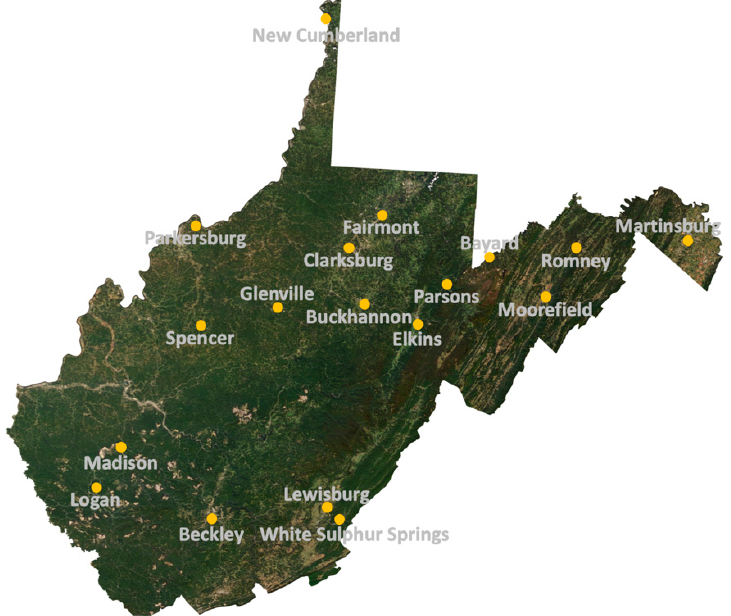
Figure 1. Observed climate record site locations in West Virginia, USA. Satellite image credit: National Aeronautics and Space Administration (NASA; [19]).